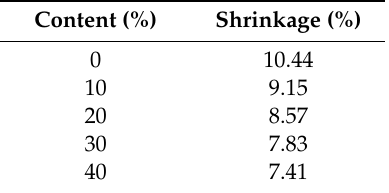
Table 1. The shrinkage of the samples with di ff erent content of epoxy resin.